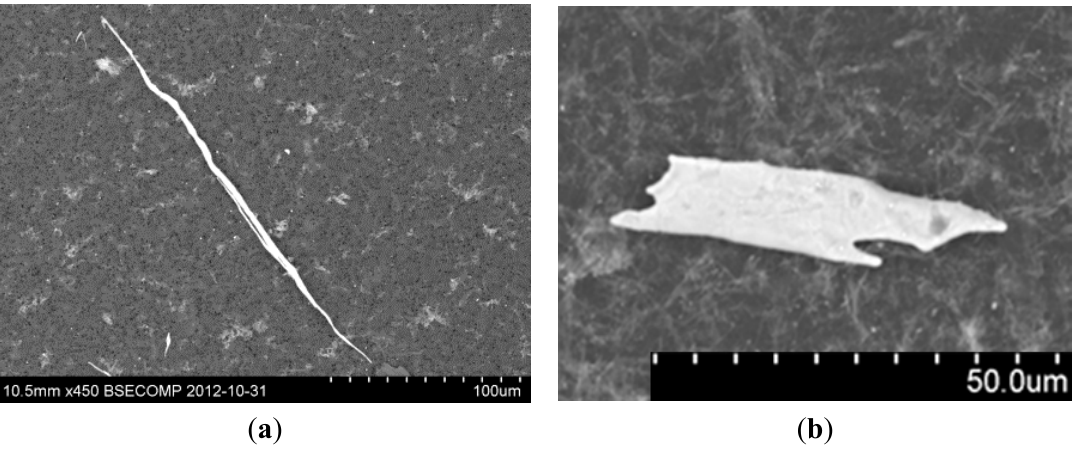
Figure 14. The typical morphology of a deformed sulfide [49]. ( a ) Rod-like and elongated MnS; and ( b ) Leaf-like deformed MnS inclusion.